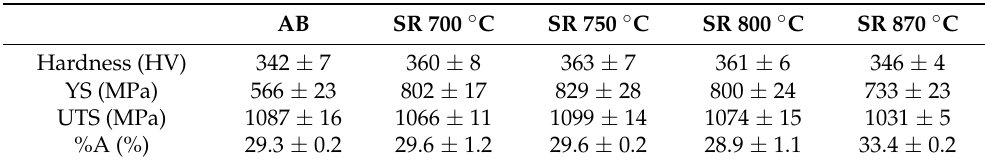
Table 2. YS, UTS, and %A values with relative standard deviation for each process condition based on tensile test